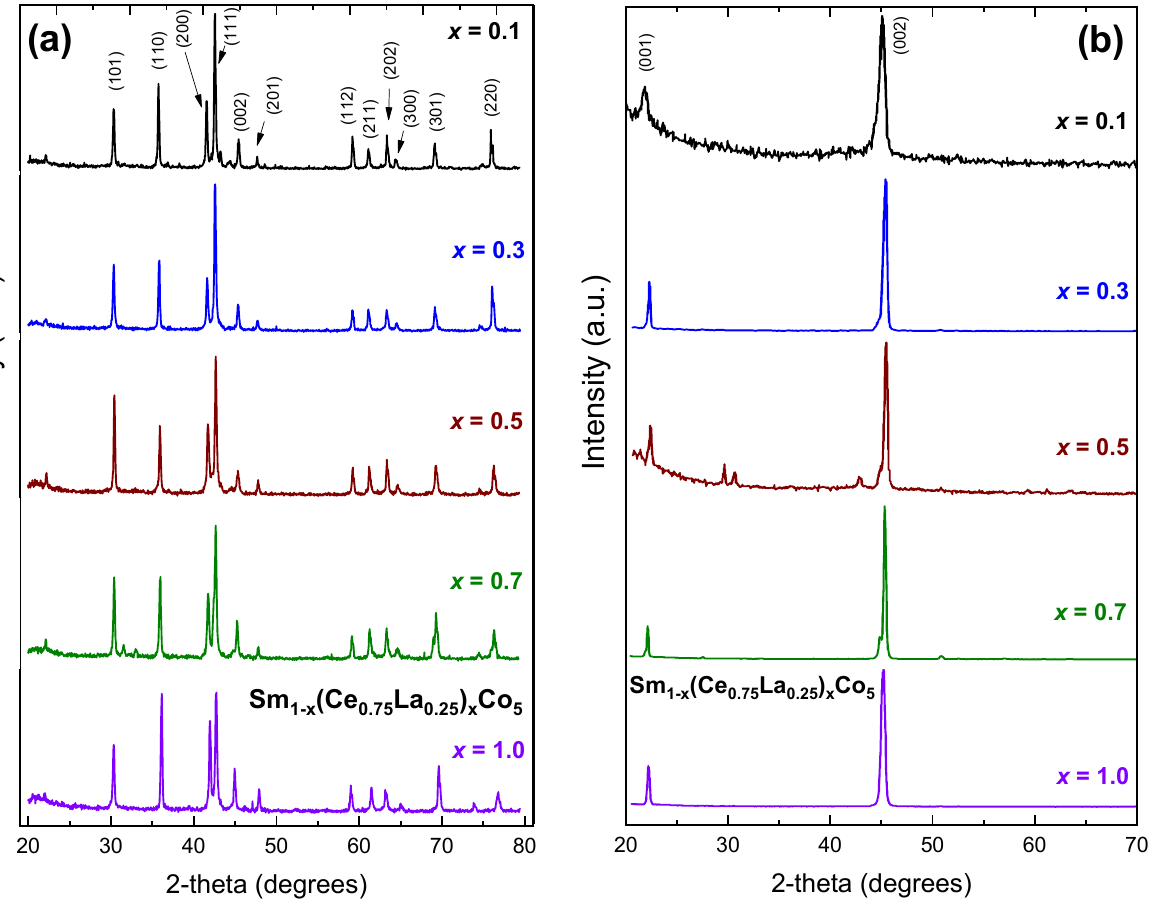
Figure 1. X-ray diffraction plots (Cu Κα radiation) of Sm 1−x (Ce 0.75 La 0.25 ) x Co 5 (x = 0.1–1.0) compounds; ( a ) powder samples; ( b ) magnetically oriented samples.